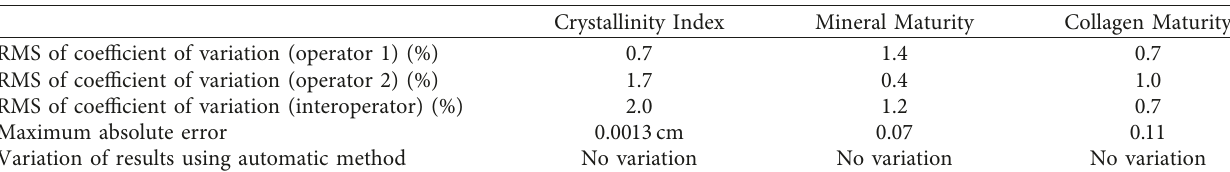
Table 2: Differences of the manual peak fitting analysis intraoperator, interoperator, maximum absolute error, and variation of results using the automatic method for each parameter, based on the analysis of 5 bone spectra. Operator 1 is an experienced operator, and operator 2 is an inexperienced operator to whom has been given the instructions to analyse the